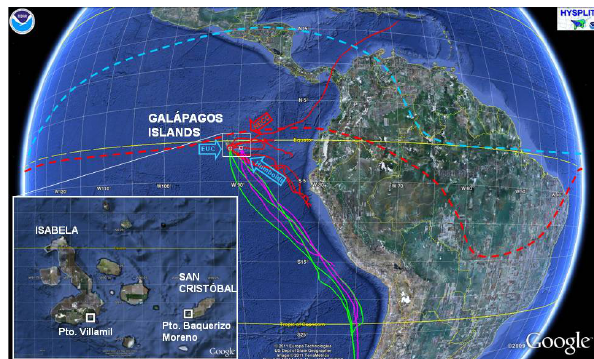
Fig. 1. Location map showing the oceanic and atmospheric cir- culation systems influencing the Galápagos archipelago. A se- lection of typical five-day back-trajectories calculated with the HYSPLIT (http://ready.arl.noaa.gov/HYSPLIT.php) Lagrangian in- tegrated trajectory model are shown in red (March 2011), green (June 2011) and violet (October 2011). Arrows refer to major oceanic currents: the North Equatorial Countercurrent (NECC), Humboldt Current and Equatorial Undercurrent (EUC). Dashed lines indicate the approximate position of the Inter-Tropical Con- vergence Zone (ITCZ) in January (red) and July (light